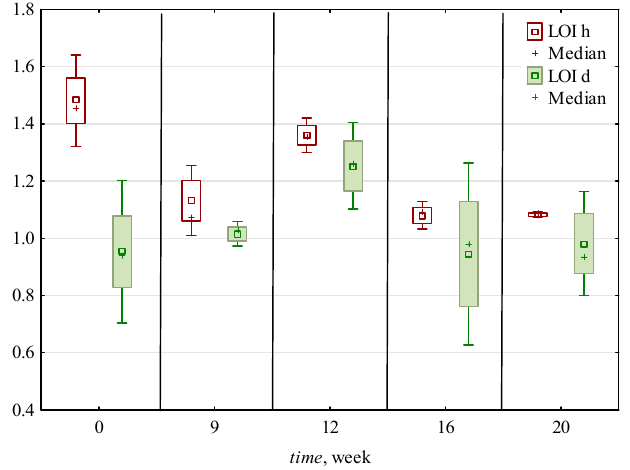
Figure 8. Values of LOI; h —peak height, d —peak deconvolution, □ —mean, frame— SE , and whisker— SD .